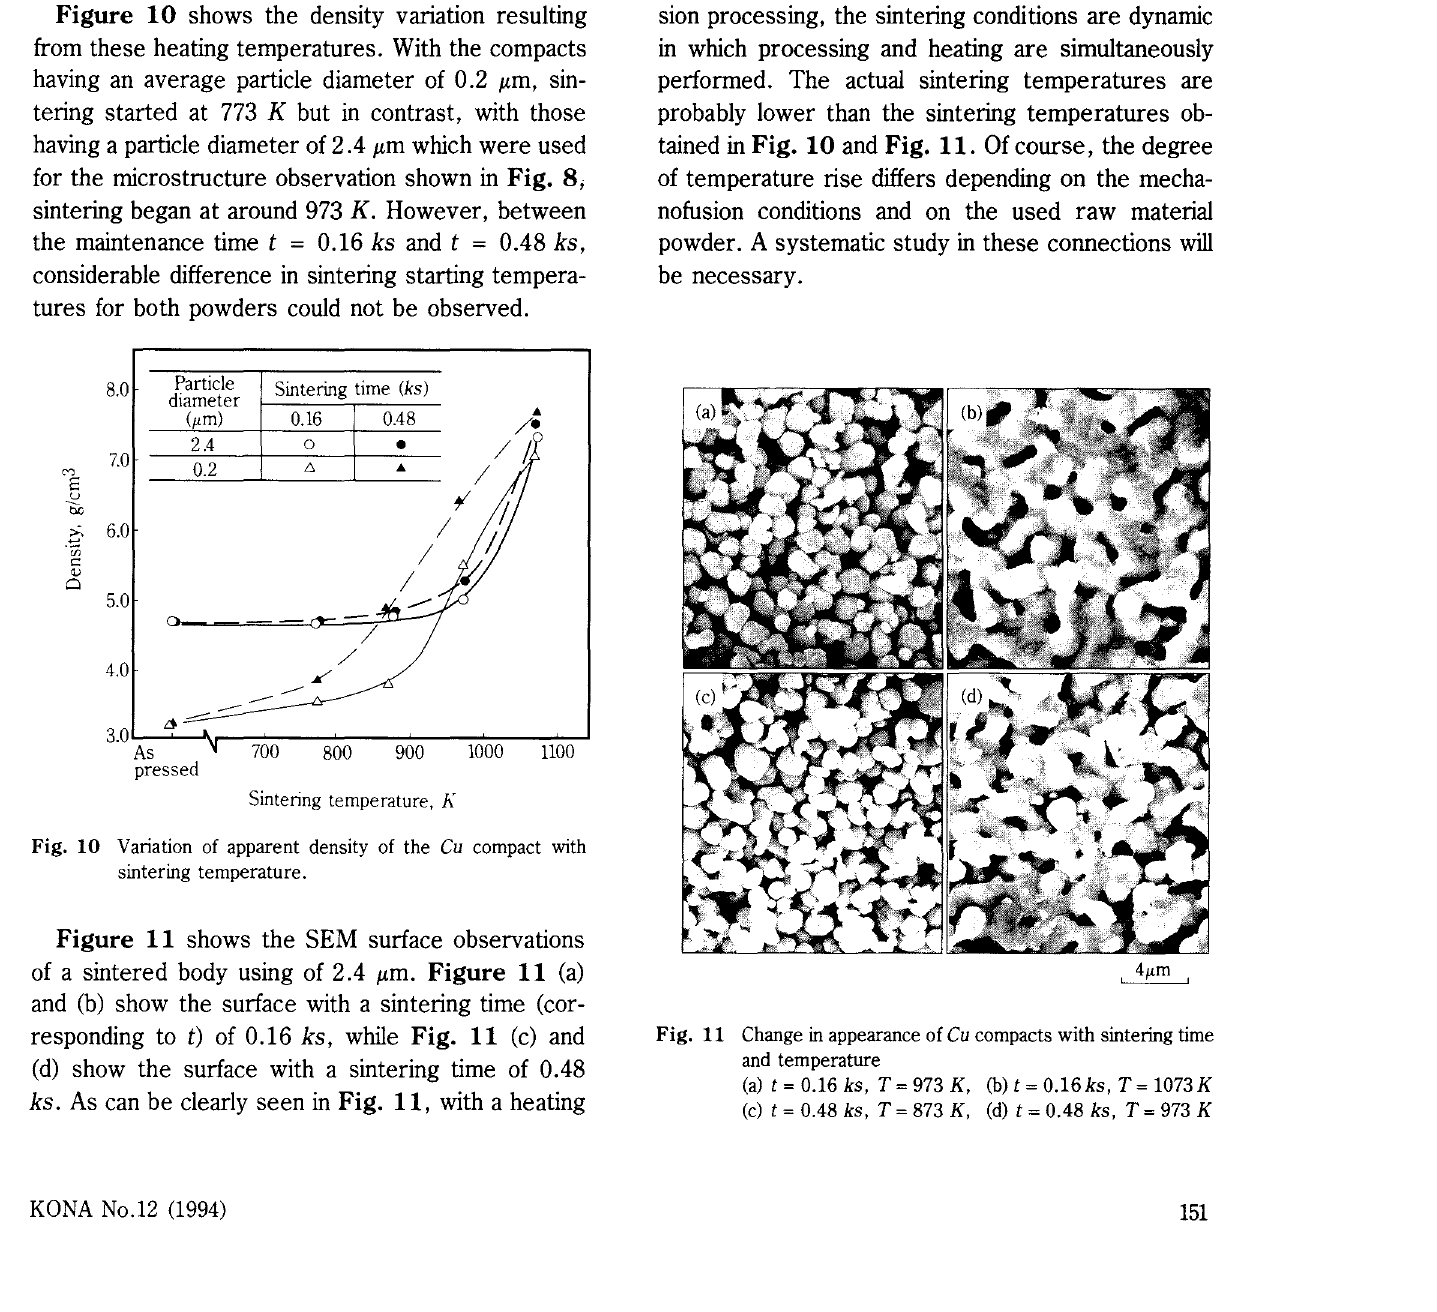
Fig. 10 Variation of apparent density of the Cu compact with sintering temperature.